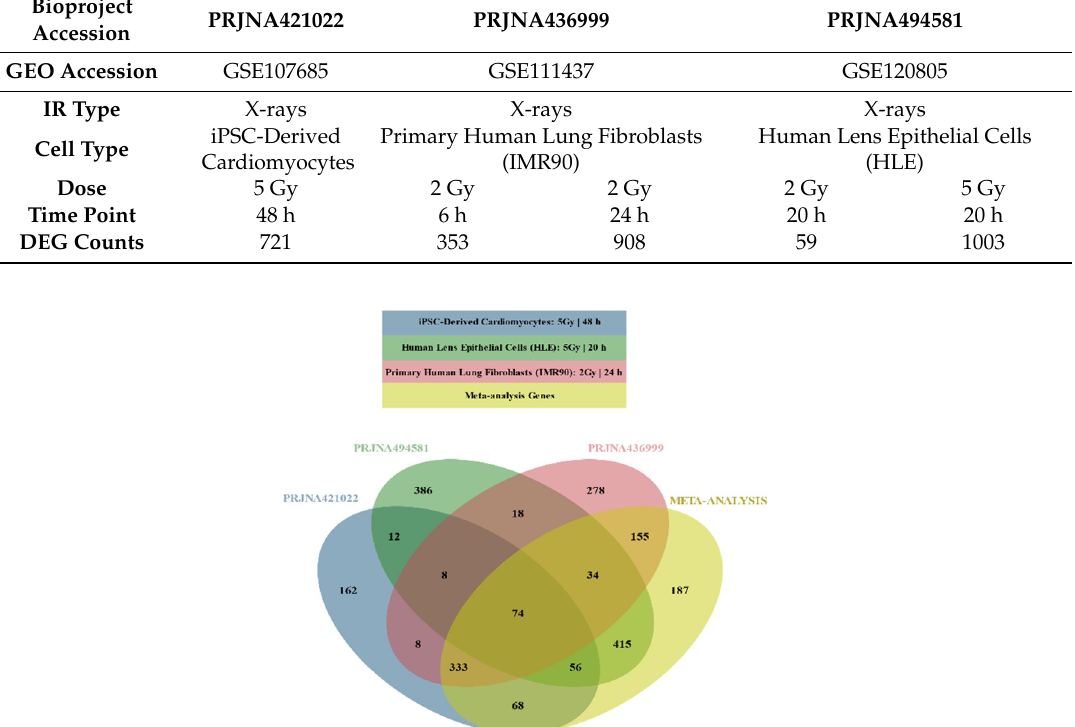
Table 3. Enriched biological processes (Gene Ontology—GO) and enriched biological pathways (KEGG) for up- and down-regulated genes after meta-analysis.